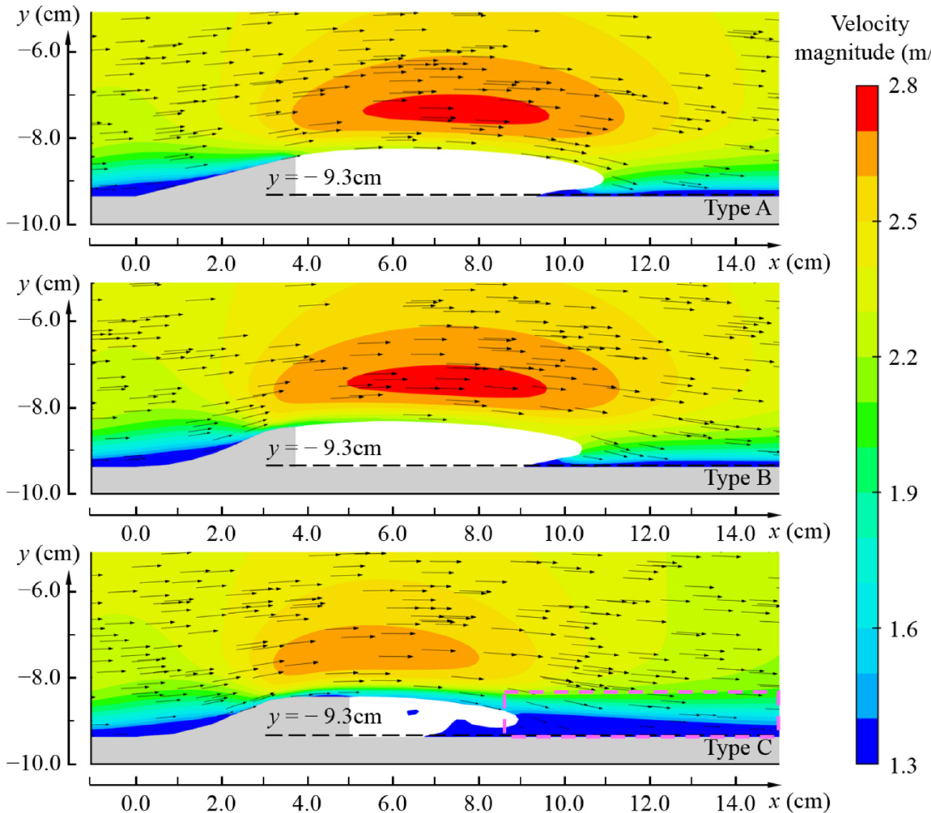
Figure 7. Horizontal velocity distribution around the deflectors at z = 1.0 cm. The vectors are generated using the same density and scale for the three types of deflectors.